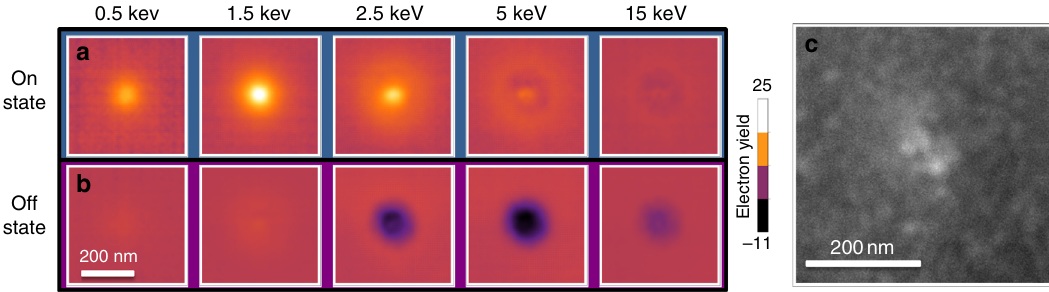
Fig. 5 Micrographs of fi lament. a Electron beam-induced current micrograph series showing contrast evolution with beam energy for the on state and b for the off state. The on-state signal maximum implies the signal is due to absorption in the top electrode, whereas the the off-state signal minimum implies the signal is due to absorption in the TiO 2 layer. c Scanning electron micrograph of the device after switching showing no tears in the electrode